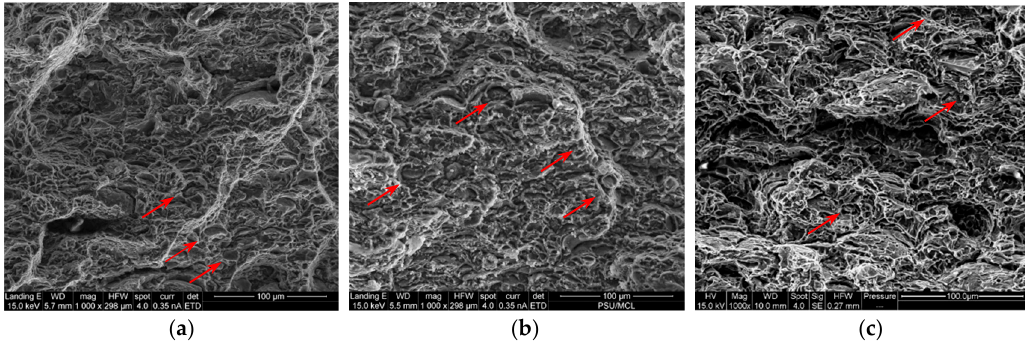
Figure 18. Secondary electron images of cold-sprayed Al 6061 fracture surfaces. The fractography predominately shows the failure mode to be ductile in nature in ( a ) 25% stress, ( b ) 65% stress, and ( c ) 85% stress conditions. Smooth particle–particle fracture can be observed (arrows).